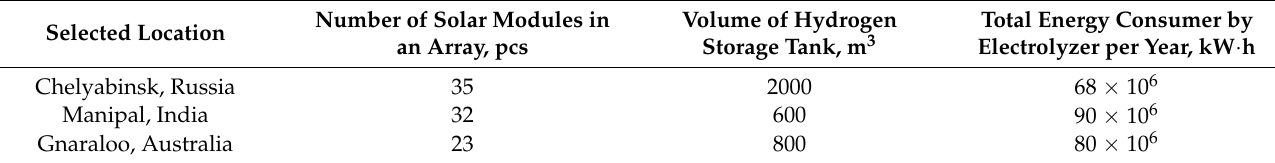
Table 4. Comparison of the optimized equipment components’ capacities and time of electrolyzer operation. Number of Solar Modules Selected Location